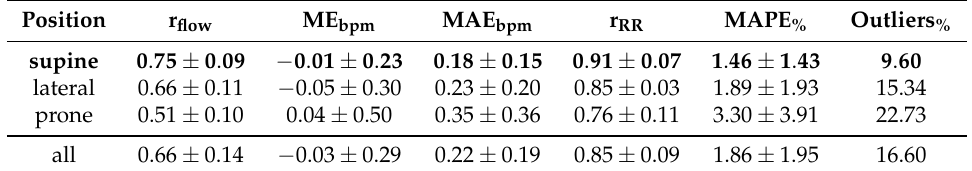
Table 4. Performances of the respiratory signal and rate estimations in the individual positions for maximum r flow feature selection optimization. The percentage of outliers removed is given.